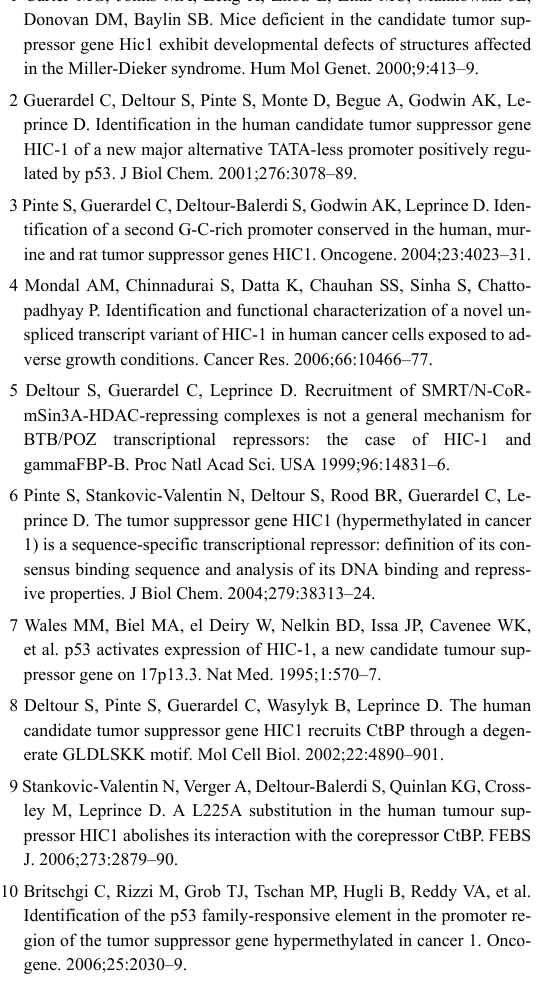
Figure 2 HIC1 regulation in acute promyelocytic leukaemia (APL). ( A ) NB4 APL cells were differentiated towards granulocytes in vitro for times indicated using 1 µM all -trans retinoic acid (ATRA). Successful differentiation was confirmed by morphology and FACS analysis of CD11b surface expression. Total RNA was extracted and levels of HIC1 mRNA were assessed using real-time quantitative RT-PCR. mRNA levels are expressed as n-fold changes in regulation compared to untreated cells using HMBS mRNA expression as a reference gene. ( B ) Bisulphite sequencing of NB4 APL and U2OS osteosarcoma cells. Top: Genomic organisation of the HIC1 promoter region highlighting the analysed CpG island. Methylation was assessed by sequencing of three individual clones derived by PCR on bisulphite-treated genomic DNA. Black circles represent methylated CpG sites, white circles unmethylated CpG sites, and each horizontal line indicates an individual allele. ( C ) Putative retinoic acid receptor binding element in the HIC1 promoter. Homologies to a region 5’ of exon 2 as well as orientation of the two core motifs are